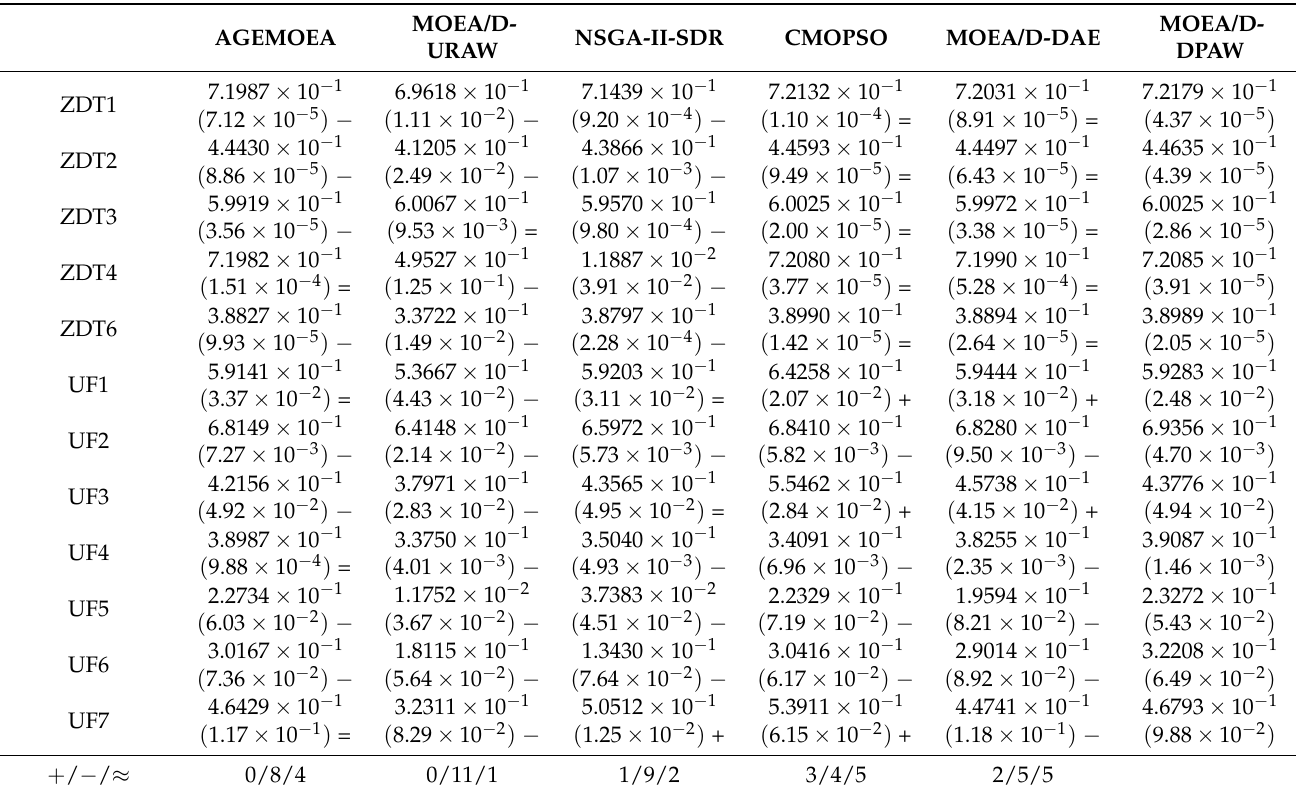
Table 2. HV values obtained by six algorithms about two-objective optimization problems on ZDT and UF.